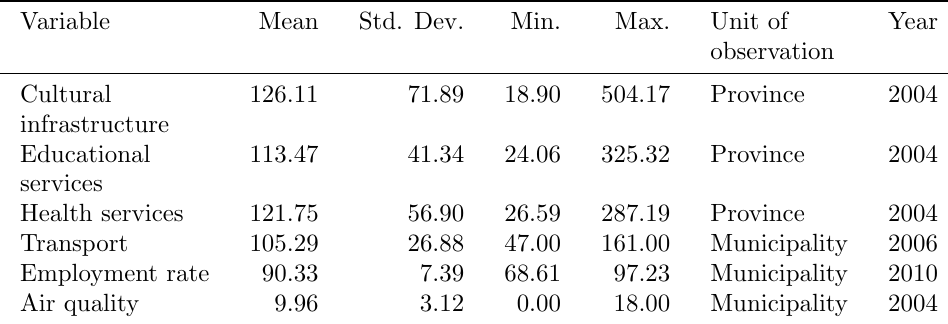
Table 1: Summary statistics of amenity